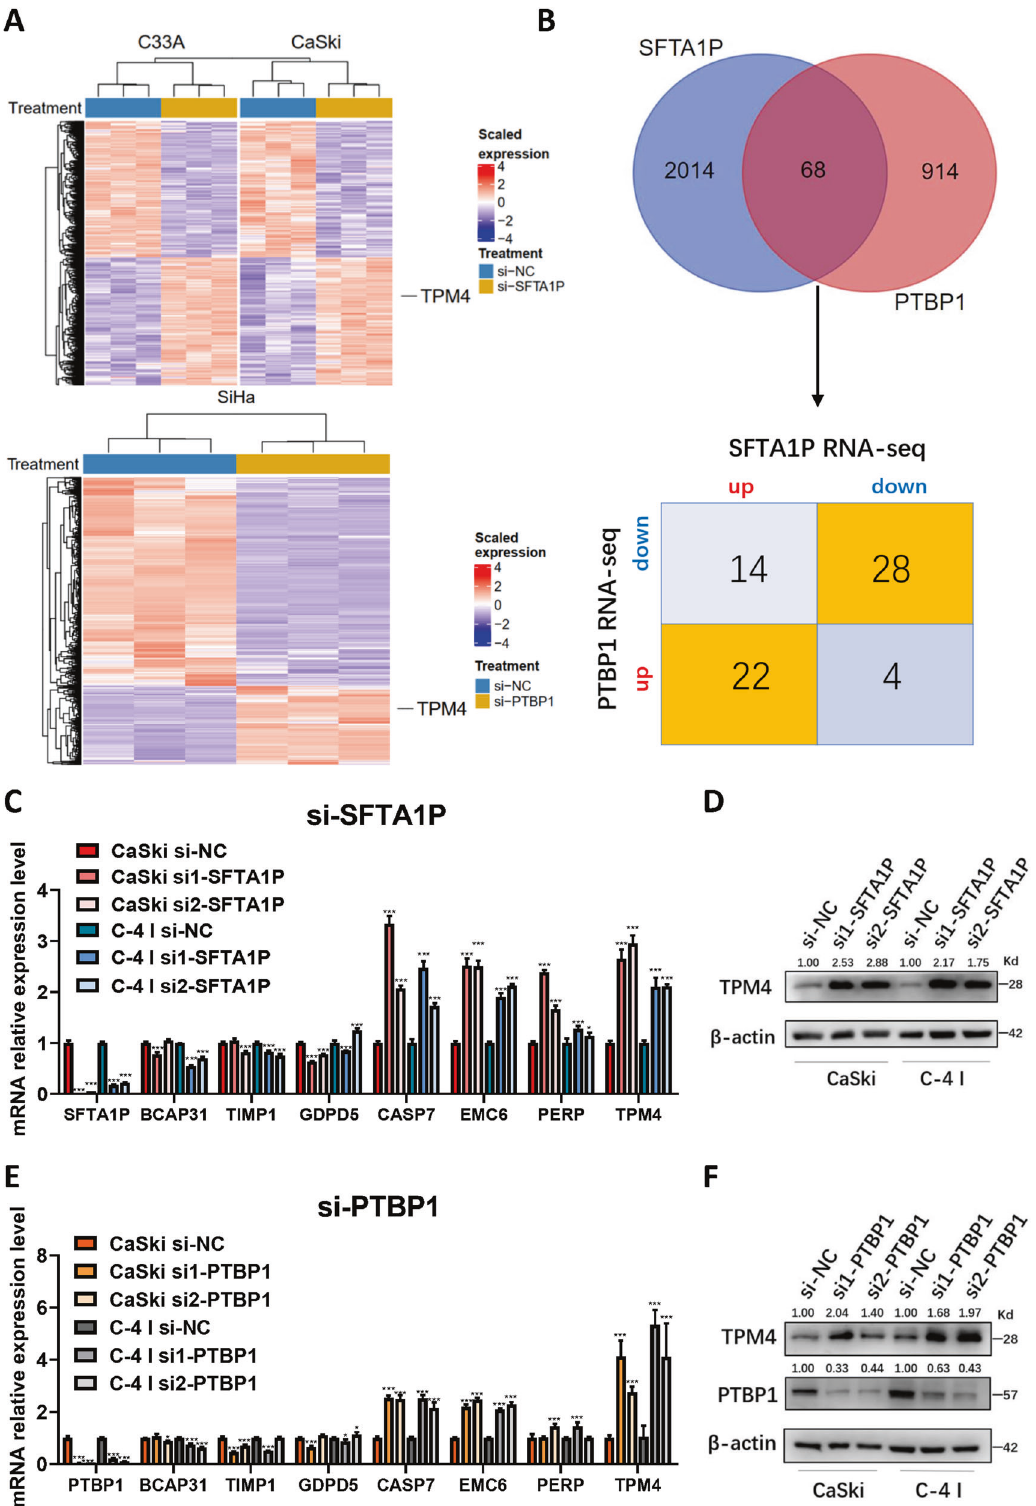
Fig. 5 TPM4 is a downstream gene of SFTA1P and PTBP1 in cervical cancer cells. A Heatmap of differentially expressed genes upon knockdown of SFTA1P in C33A and CaSki and knockdown of PTBP1 in SiHa cells, revealed by RNA-seq. B Venn diagrams of differentially expressed genes (DEGs) identi fi ed by SFTA1P RNA-seq and PTBP1 RNA-seq (upper) and intersecting DEGs after knockdown of SFTA1P and PTBP1 (lower). C Eight key candidate downstream genes were selected based on our RNA-seq data and literature review, and subsequently evaluated by RT-PCR in CaSki and C-4 I cells transfected with SFTA1P siRNA. D Western blot analysis of TPM4 in CaSki and C-4 I cells with SFTA1P knockdown. E Eight key candidate downstream genes were evaluated by RT-PCR in CaSki and C-4 I cells transfected with PTBP1 siRNA. F Western blot analysis of TPM4 in cervical cancer cells with PTBP1 knockdown. Data are shown as mean ± SEM. * P < 0.05; ** P < 0.01; *** P < 0.001.